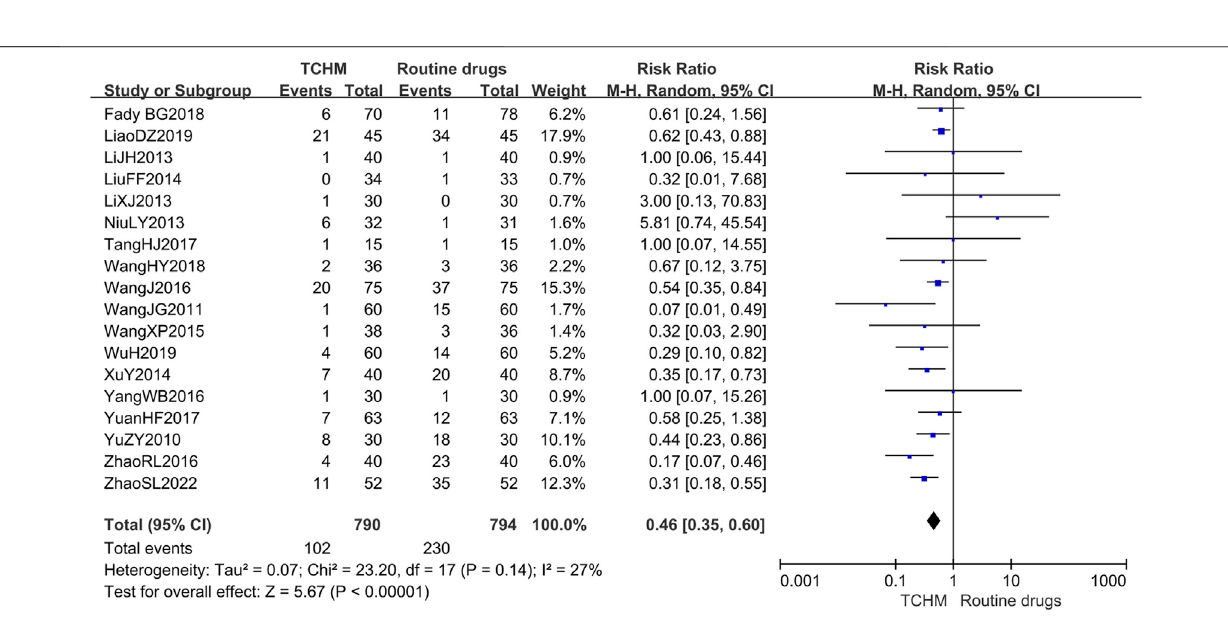
Frontiers in Pharmacology |